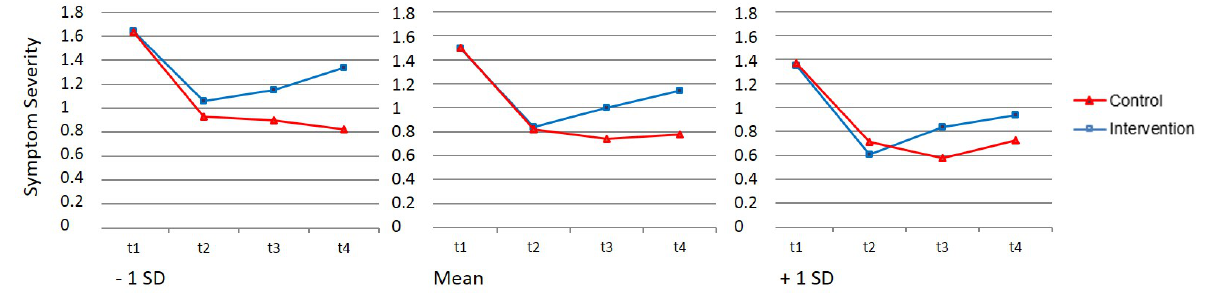
Figure 4. Estimated course of symptoms based on simple slope mixed-effect model analyses for significant moderator positive outcome expectations (mean vs mean – 1 SD vs mean + 1 SD) at inpatient admission (T1), inpatient discharge/begin transdiagnostic Internet-based maintenance treatment (T2), 3-month follow-up/end transdiagnostic Internet-based maintenance treatment (T3), and 12-month follow-up (T4).